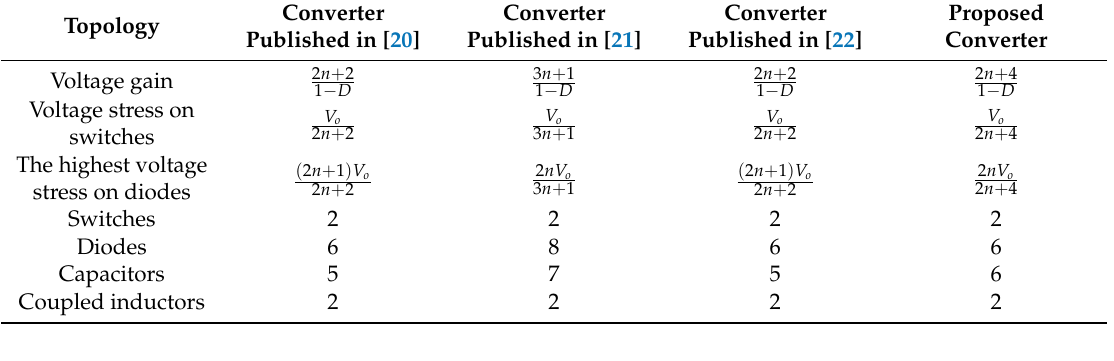
Table 1. Converter performance comparison.